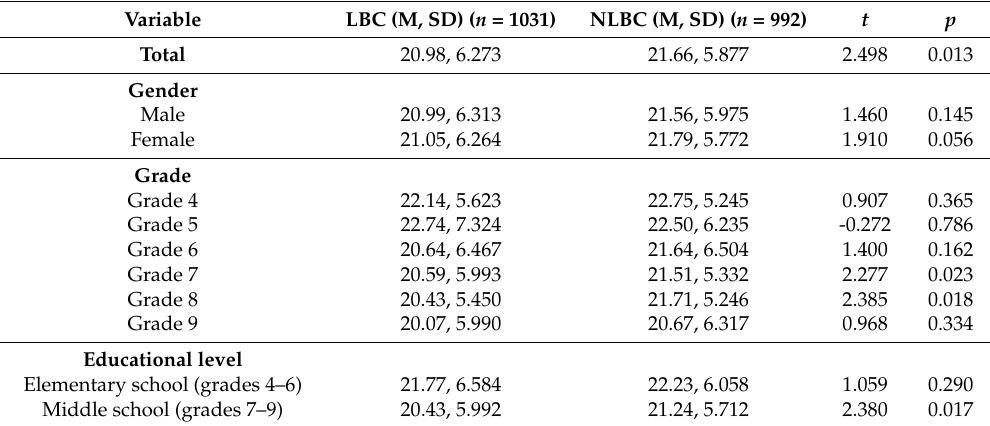
Table 2. Comparison of life satisfaction of left-behind children (LBC) and non-left behind children (NLBC) in rural